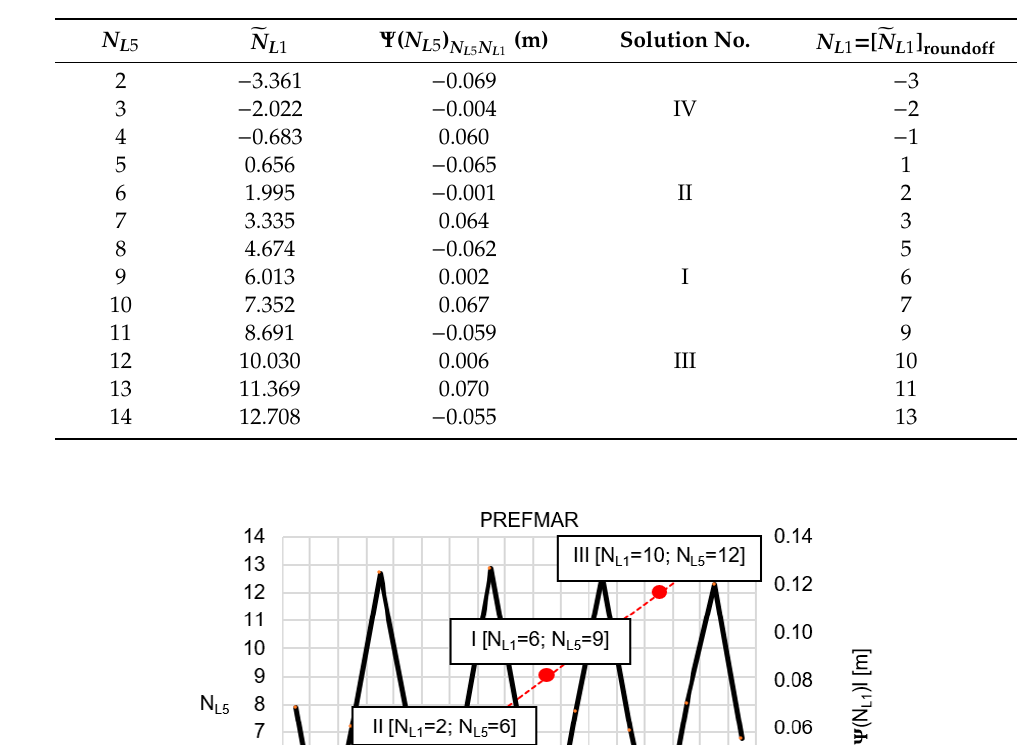
(cid:101) N L 5,0 = 8.349 and N L 5 N L 1 , for